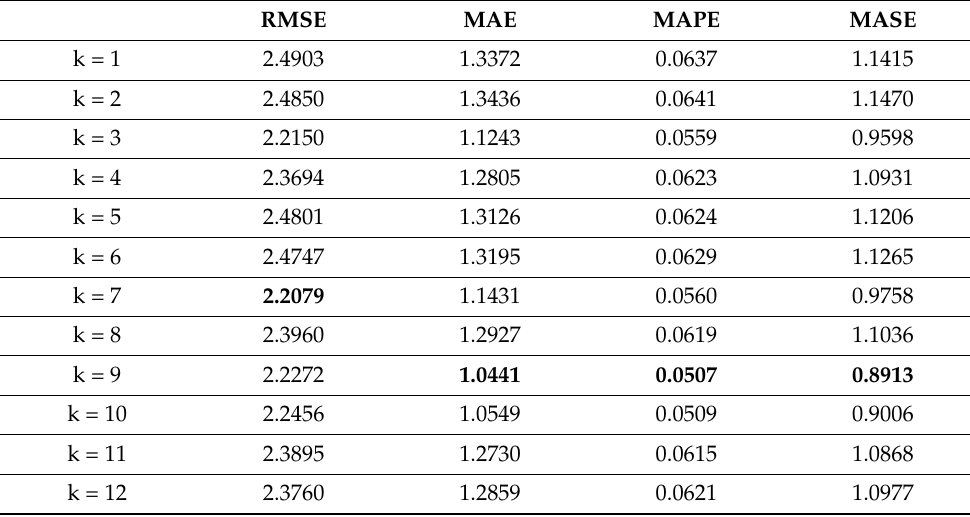
Table 4. In-sample forecast accuracy for BSR models with the different number of linear components